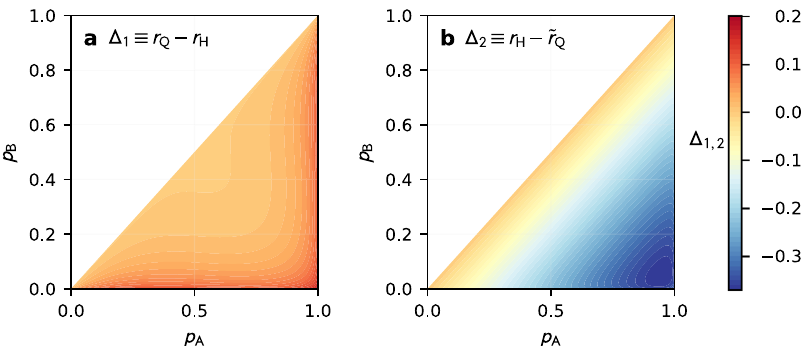
Fig. 2 Comparison between robustness bounds in terms of trace distance. a Difference r Q − r H between the pure state bound derived from QHT r Q , given in Eq. (16) and the Hölder duality bound r H from Lemma 2. b Difference r H (cid:2) e r Q between the Hölder duality bound r H and the bound e r Q derived from the convex hull approximation to the QHT robustness condition from Theorem 1 for mixed adversarial states. It can be seen that the pure state bound r Q is always larger than r H which in turn is always larger than the convex hull approximation bound e r Q